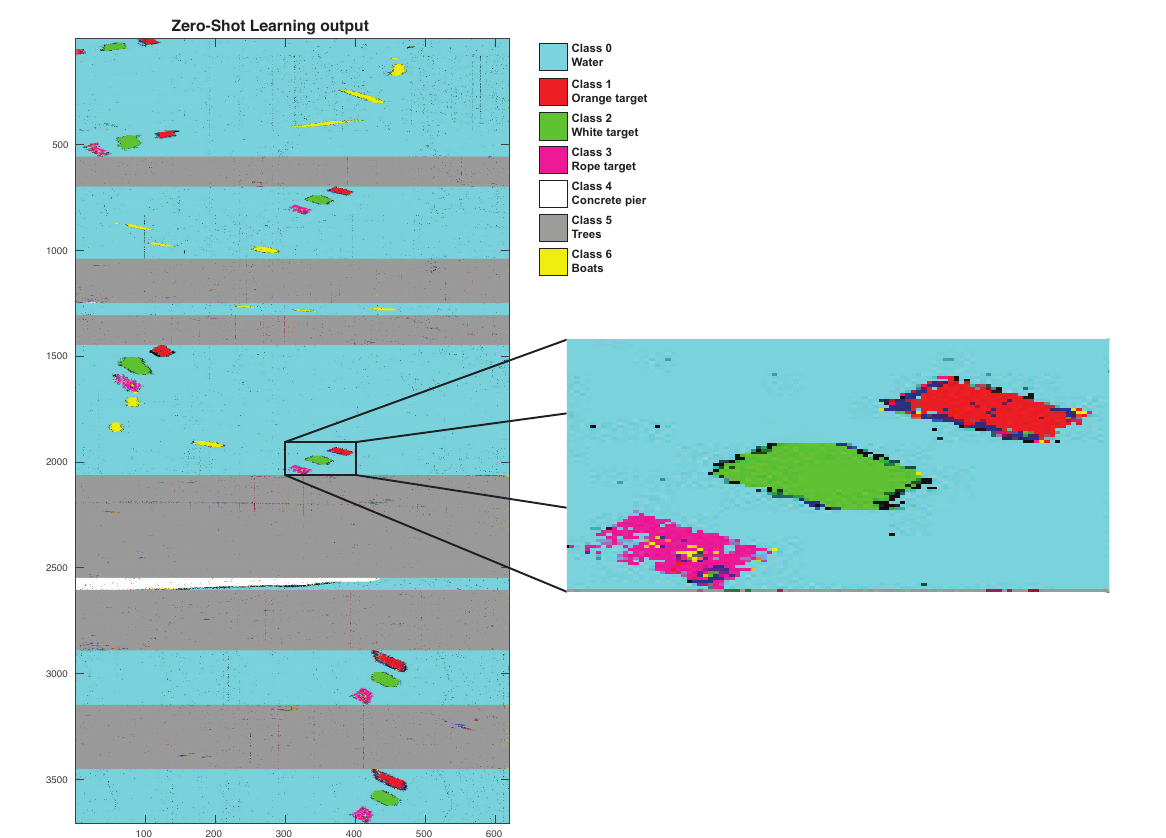
Figure 9. Zero-shot learning results zooming on one of the artificial target’s detections (including the two unknown classes (class 1, identified with the colour red, and class 3, identified with the colour pink).